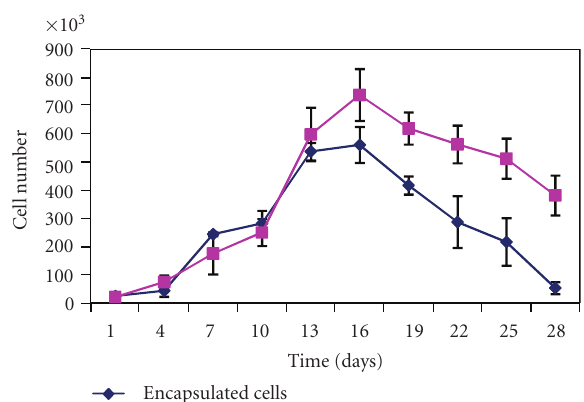
Figure 3: The quantity of secreted VEGF 165 b from encapsulated and nonencapsulated HEK293 VEGF 165 b producing cells deter- mined by ELISA.